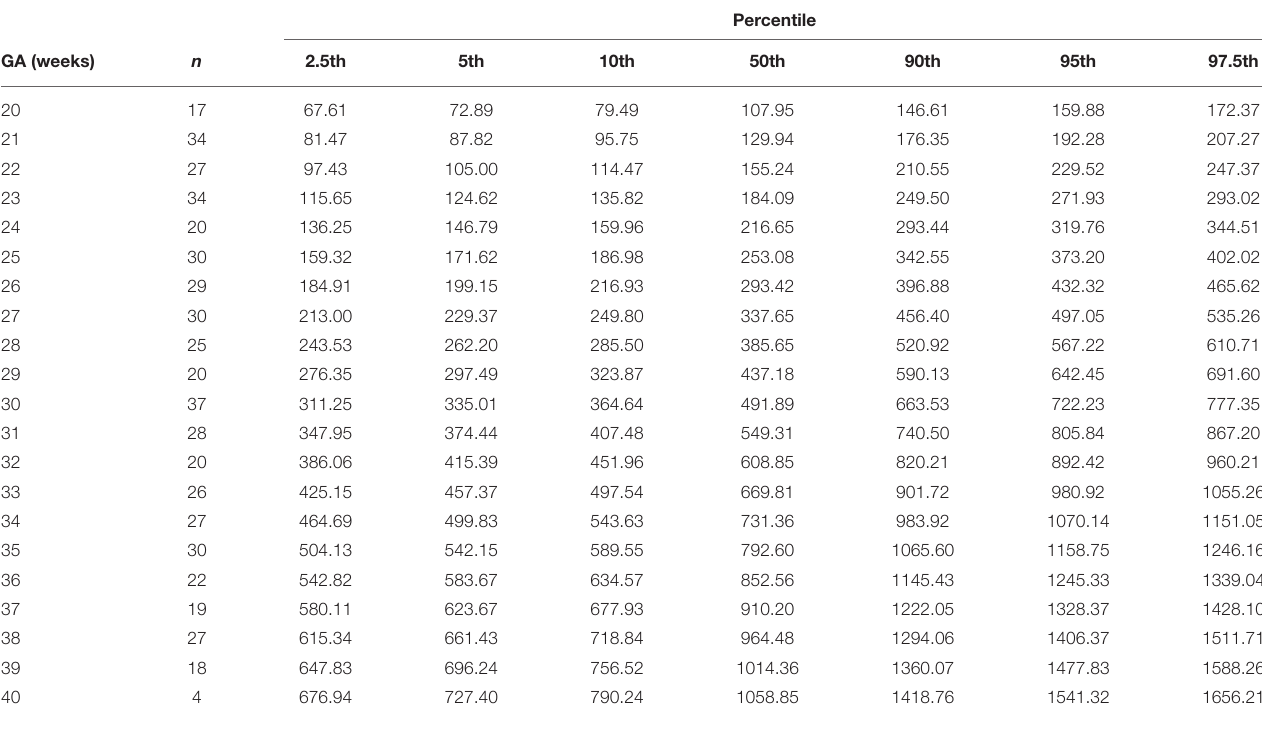
TABLE 8 | Percentiles of right ventricular cardiac output (ml/min) at 20–40 weeks of gestational age (GA).